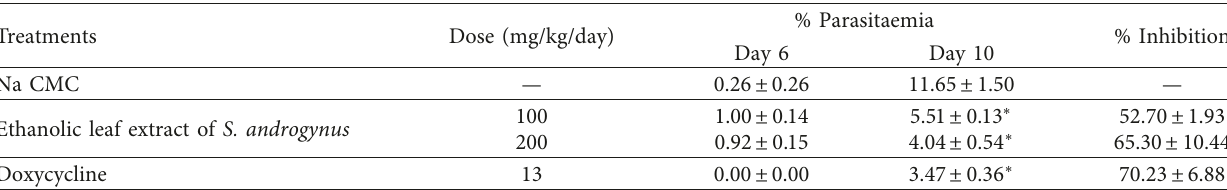
Ethanolic leaf extract of S. androgynus